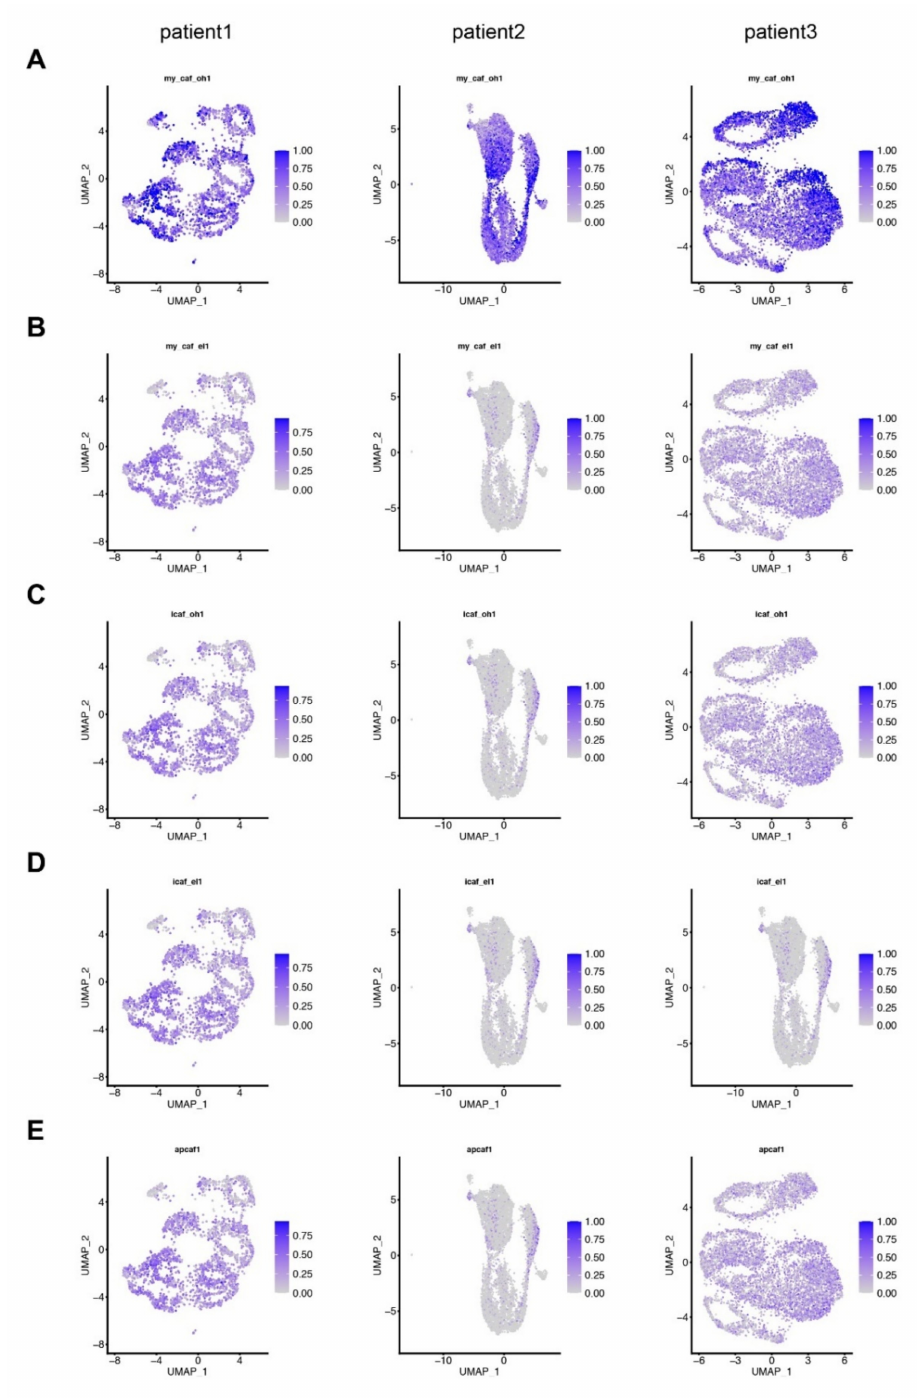
Figure 7. No myofibroblastic, inflammatory or antigen-presenting cancer-associated fibroblast- specific cluster, but exhibit myCAF-like profiling in disease-associated fibroblasts from pancre- atic cancer and chronic pancreatitis patients. Cell with ( A , B ) myofibroblastic, ( C , D ) inflammatory, and ( E ) antigen-presenting cancer-associated fibroblasts are visualized in fibroblasts from pancreatic cancer and chronic pancreatitis patients. Lists of selected markers are listed Table 5, markers were selected from the publications Öhlund et al. [10] for ( A , C ), Elyada et al. [11] for ( B , D , E